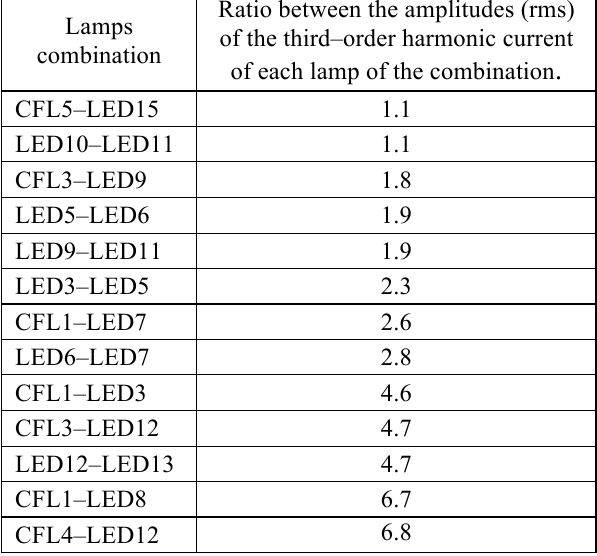
Table 3: Tested combinations of